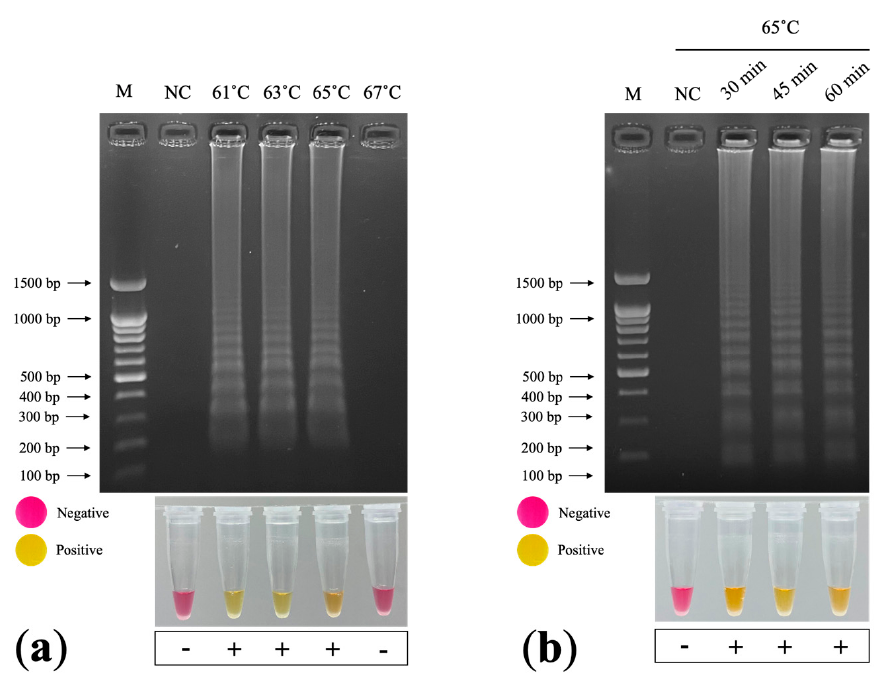
Figure 5. Optimization of colorimetric RT–LAMP TMV detection: ( a ) optimization of temperature 61, 63, 65, and 67 °C for 60 min. ( b ) optimization of incubation time 30, 45, and 60 min at 65 °C. M: 100 bp + 1.5 kb DNA ladder (SibEnzyme, Novosibirsk, Russia); NC: negative control (nuclease-free water).